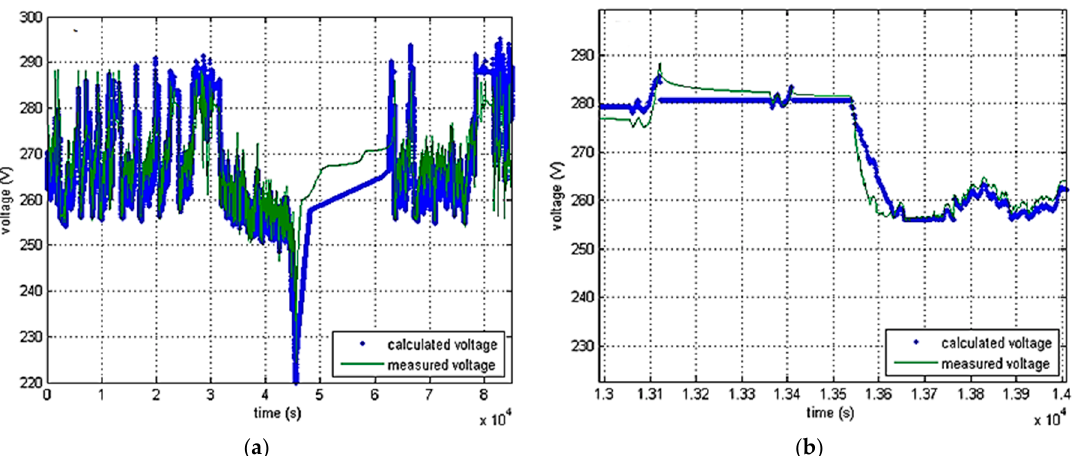
Figure 9. PFC tests, measured and calculated battery voltage vs. time: ( a ) voltage vs. time during 1 day; and ( b ) detail in the time range 13,000–14,000 s.